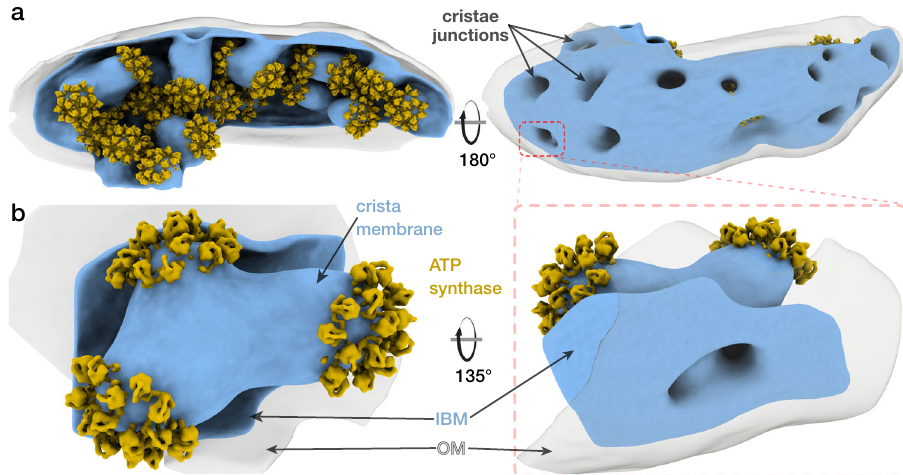
Fig. 8 Pentagonal ATP synthase pyramid arrays decorate bulbous cristae in T. gondii mitochondria. a Cryo-ET of a T. gondii tachyzoite mitochondrion (IBM, inner boundary membrane, blue; OM, outer mitochondrial membrane, grey) and subtomogram averaging of ATP synthase dimers (yellow). Cristae are connected to the inner boundary membrane via circular cristae junctions and decorated with pentagonal ATP synthase pyramids. b Close-up view of a crista membrane containing three bulbous protrusions, each decorated with an ATP synthase array containing ten ATP synthase